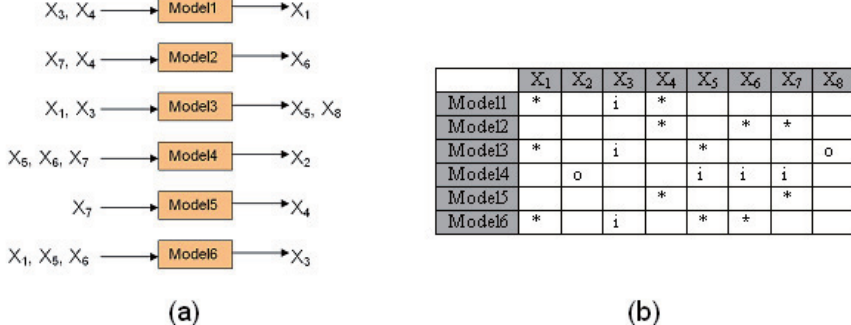
Fig. 4. (a) System of models (b) Corresponding populated incidence matrix by applying first four rules.